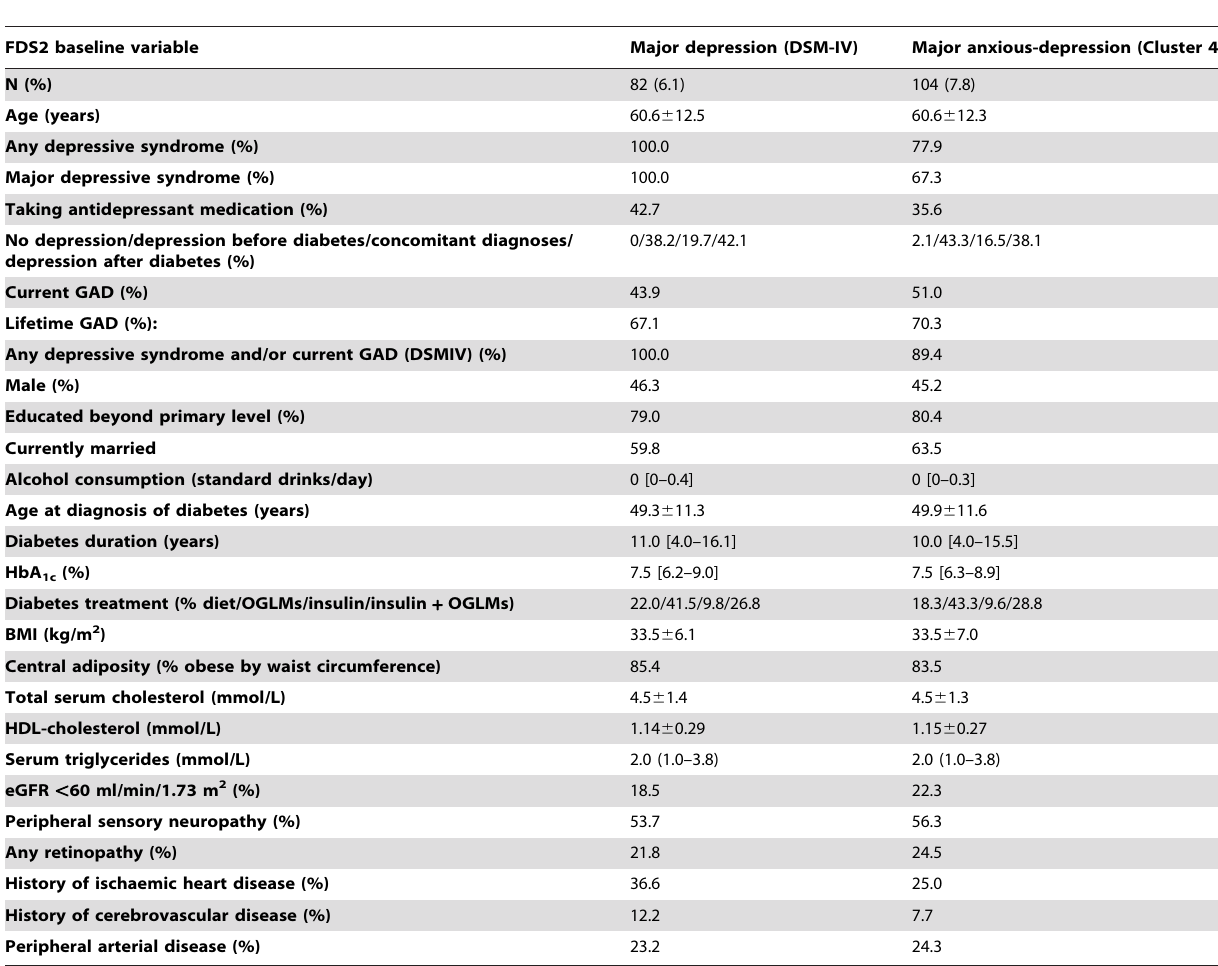
Table 5. FDS2 baseline associates of major anxious depression class vs major depression (DSM-IV criteria) in participants with type-2